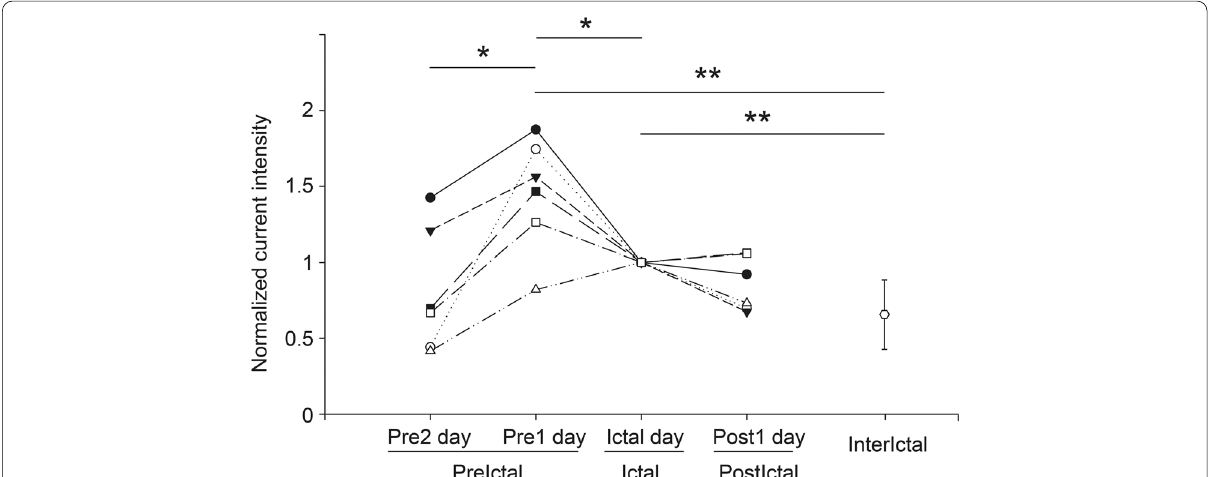
Fig. 5 Brainstem activation during migraine cycle. Differences in normalised peak brainstem intensity among migraine cycles ( n phases ( Pre2 , Pre1 , Ictal , Post1, and Interictal ). *, P < 0.05; **, P < 0.01; Pre2 , 24–48 h before headache onset; Pre1 , within 24 h before headache onset; Ictal , during migraine attack; Post1 , within 24 h after headache offset; Interictal, the period ˃ 48 h between the last and next headache phase